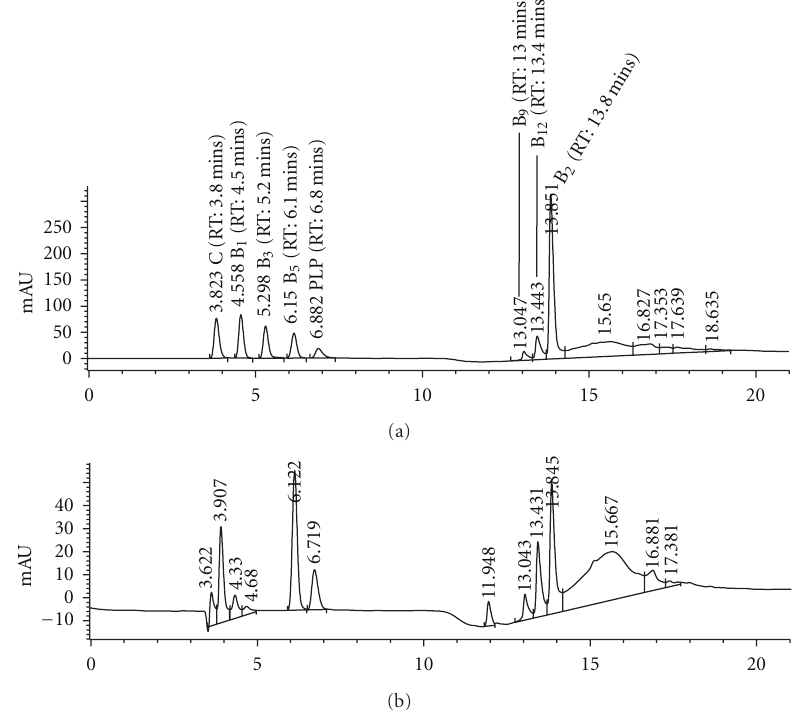
Figure 1: Vitamins mix (standards prepared in water, 20 ng/ μ L) analysed under standardised conditions reported in the main text. (a) Real plasma sample obtained from one study participant analysed under standardised conditions reported in the main text. (b) Real plasma sample was spiked with the IS (RT: